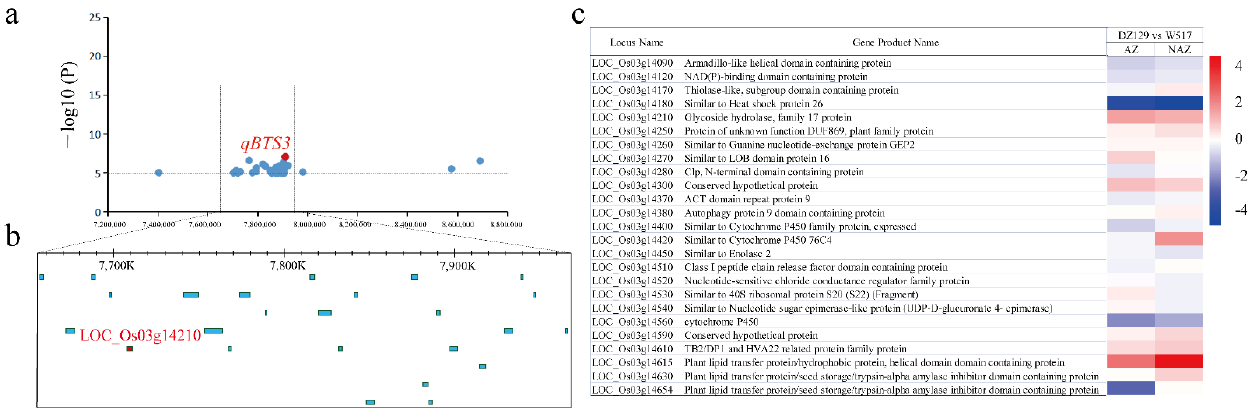
Figure 8. Identification of the candidate gene LOC_Os03g14210: ( a ) Local Manhattan plot of BTS values surrounding the peak on chromosome 3. ( b ) Identification of candidate genes in the region of qBTS3 . ( c ) The candidate genes in qBTS3 and their expression patterns in the RNA-Seq results. We carried out a gene-based haplotype- LOC_Os03g14210 analysis to confirm the as- sociation between the candidate gene LOC_Os03g14210 and seed shattering by using rese- quencing data from 480 naturally occurring rice cultivars (Table S10). Within the coding region of LOC_Os03g14210 , a total of three SNPs were identified. Of the three SNPs in the coding region, the one-nucleotide substitution, A354G, caused amino acid conversion